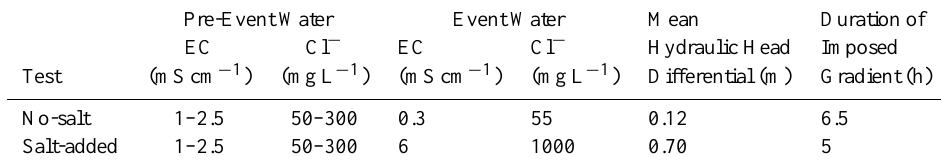
Table 1. Summary of pumping events.